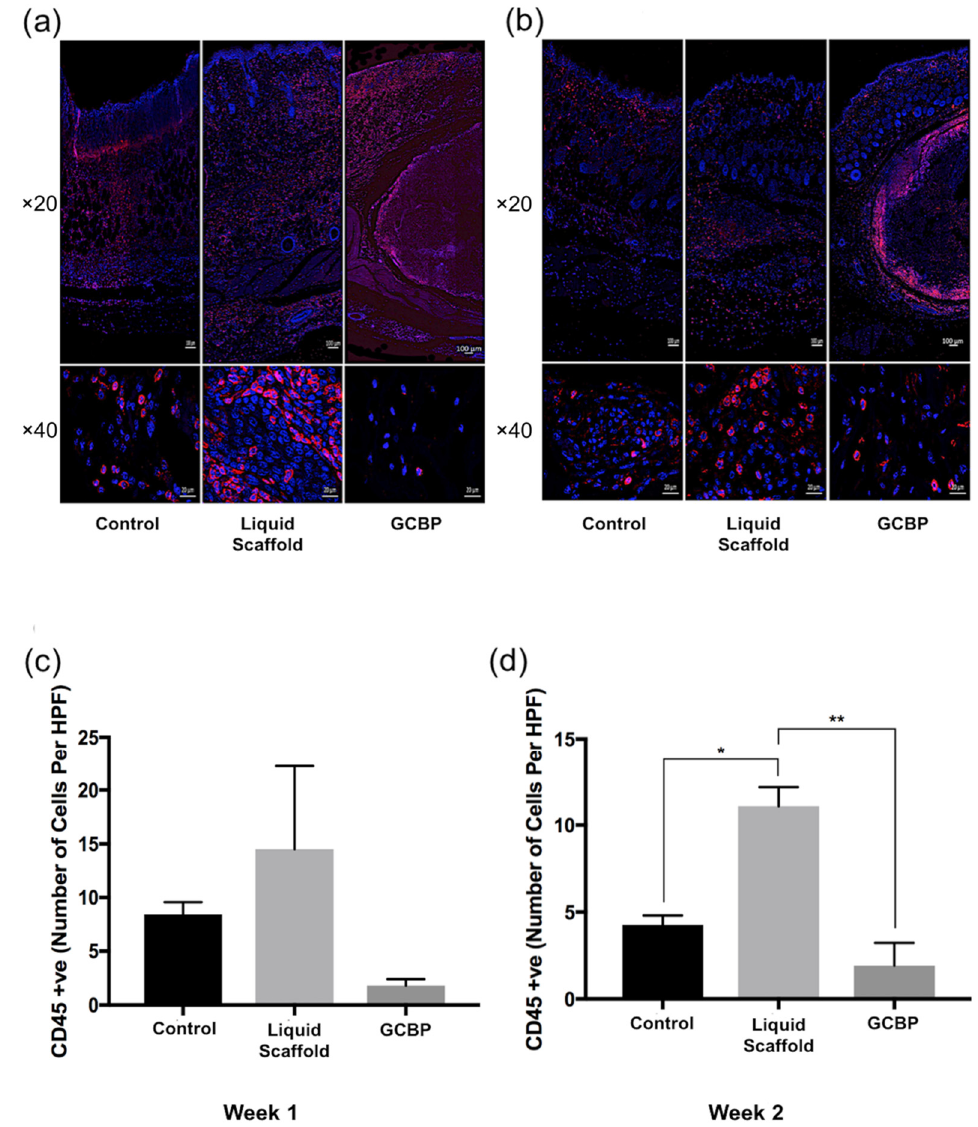
Figure 5. ( a ) Immunofluorescence staining of CD45-positive cells (red), counterstained with nuclear stain DAPI (blue) after 1 week. ( b ) IF staining of CD45+ cells after 2 weeks. ( c ) Quantification of CD45+ cells after 1 week. ( d ) Quantification of CD45+ cells after 2 weeks. CD45+ cells were the second most dominant cell type in all groups. Liquid Scaffold showed higher number of cells after 1 week, and significantly higher number after 2 weeks, compared to GCBP and the control (*, p < 0.05; **, p < 0.01). Scale bars in top and bottom rows = 100 μ m and 20 μ m, respectively.